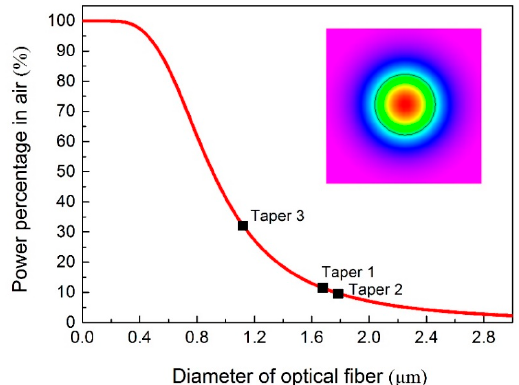
Figure 10. FEW power as a function of fiber diameter for three tapers (inset: optical field distribution for fiber taper).